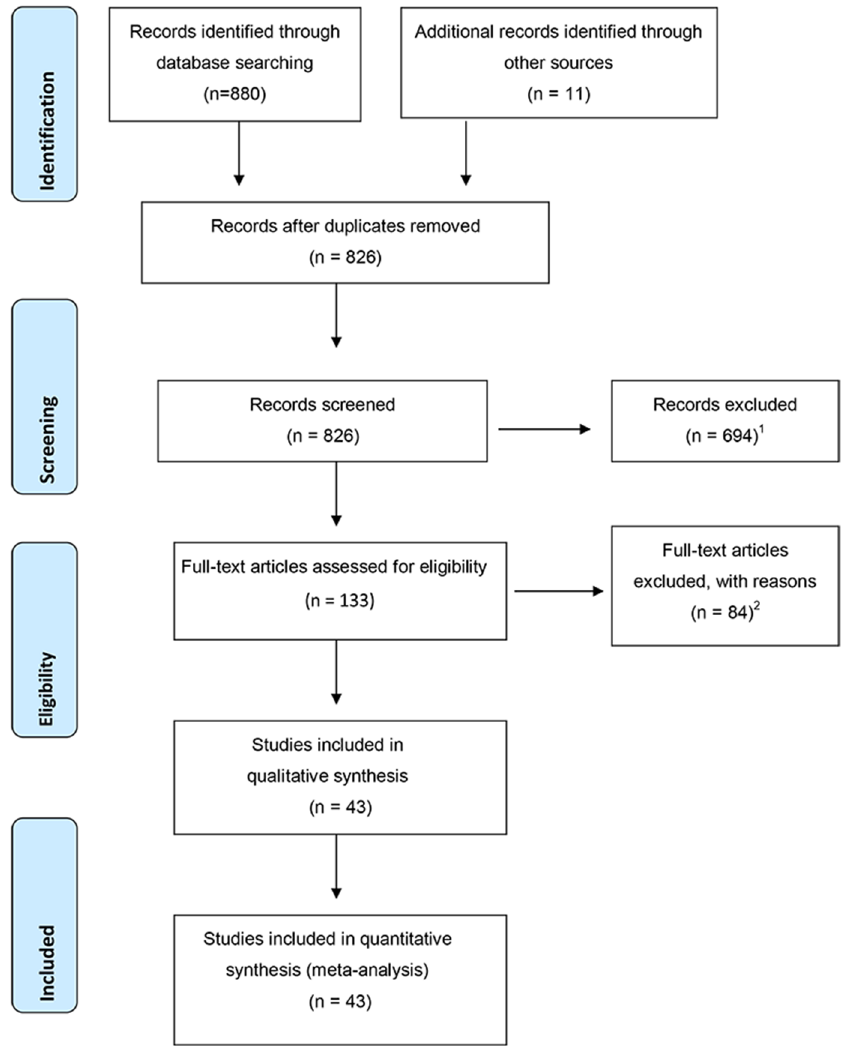
Fig 1. PRISMA flow diagram. 1 Excluded due to studies sampling populations other than college students, or not having reported prevalence of BPD, or allowing calculable prevalence of BPD. 2 As per exclusion Note 1, and also correspondence with